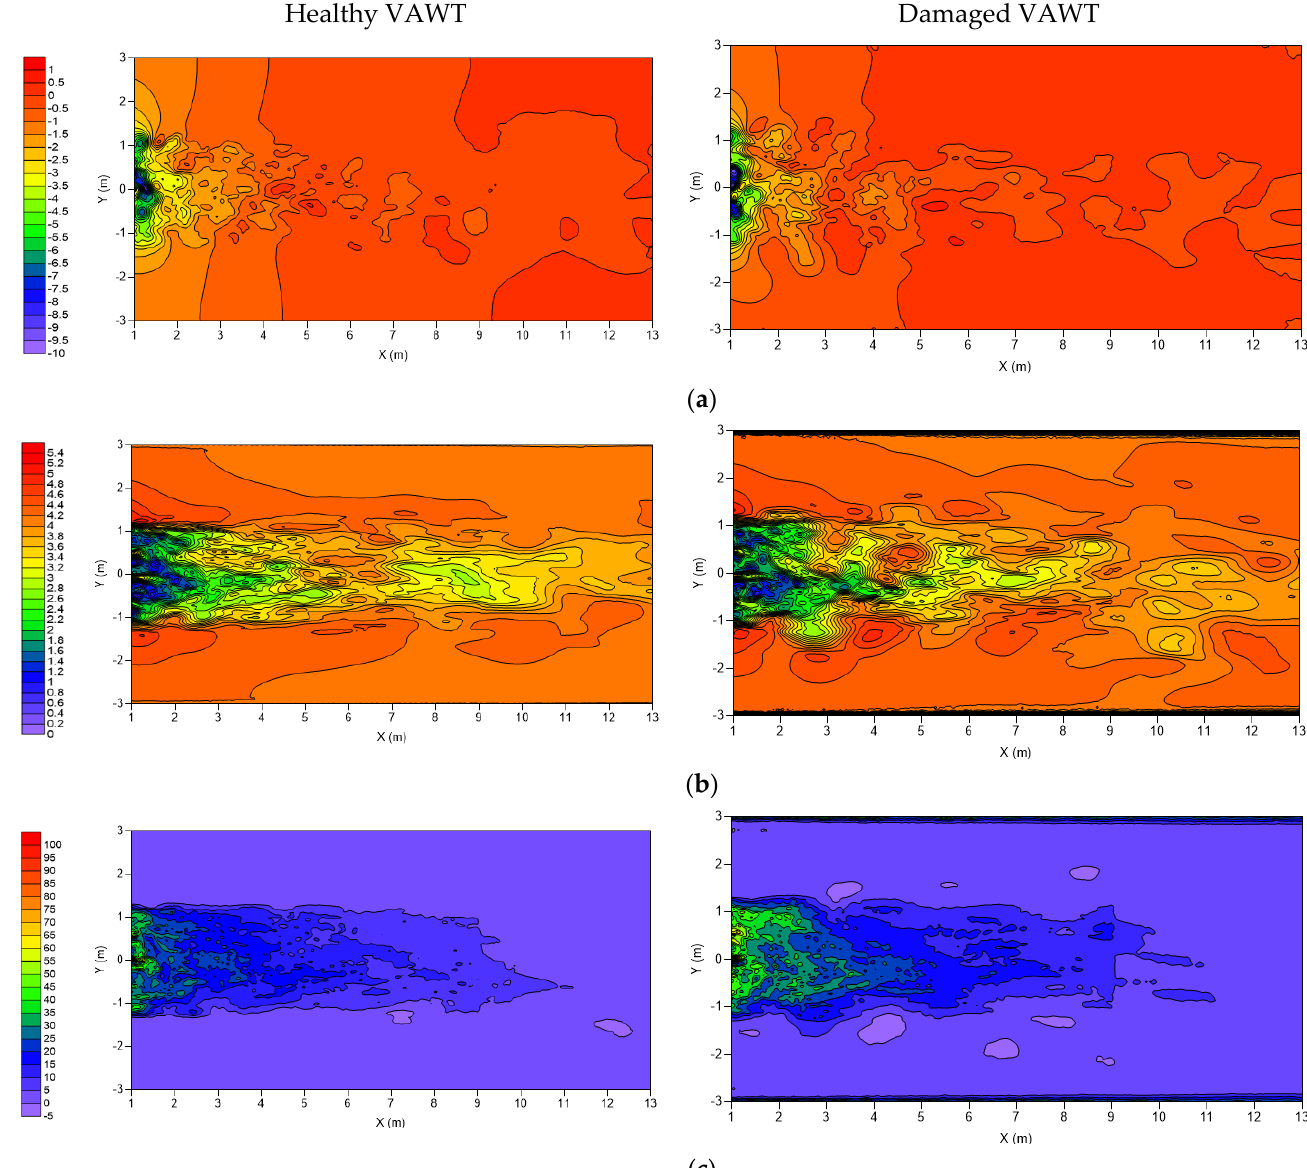
Figure 14. Reconstructed ( a ) pressure, ( b ) velocity, and ( c ) vorticity fields in the wake region of healthy and damaged VAWTs based on φ 1 .